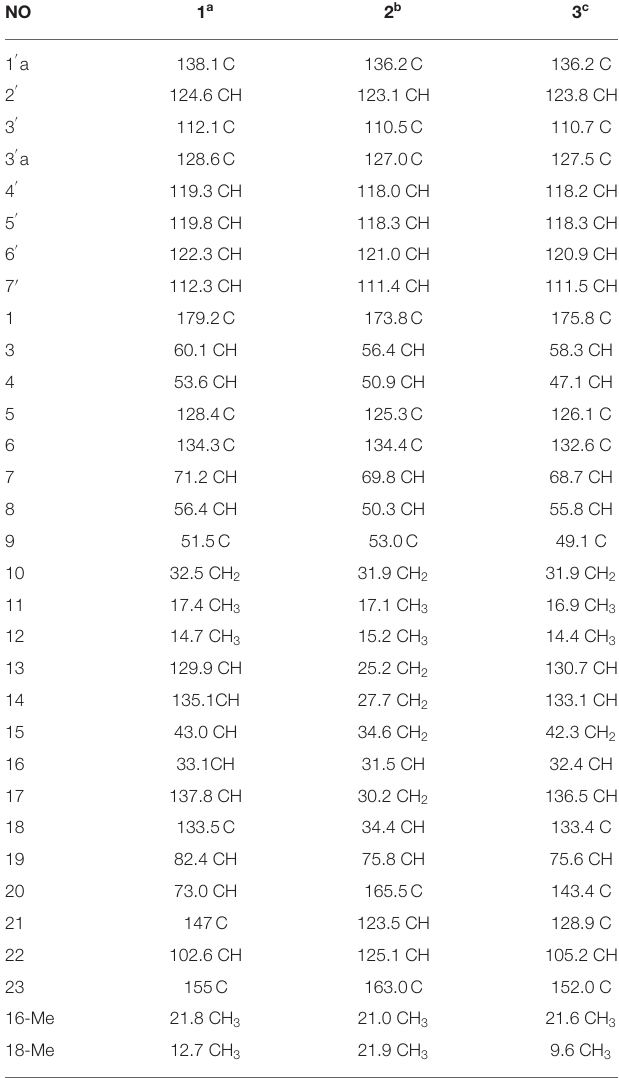
four methyl groups, two methylene units, seven methine